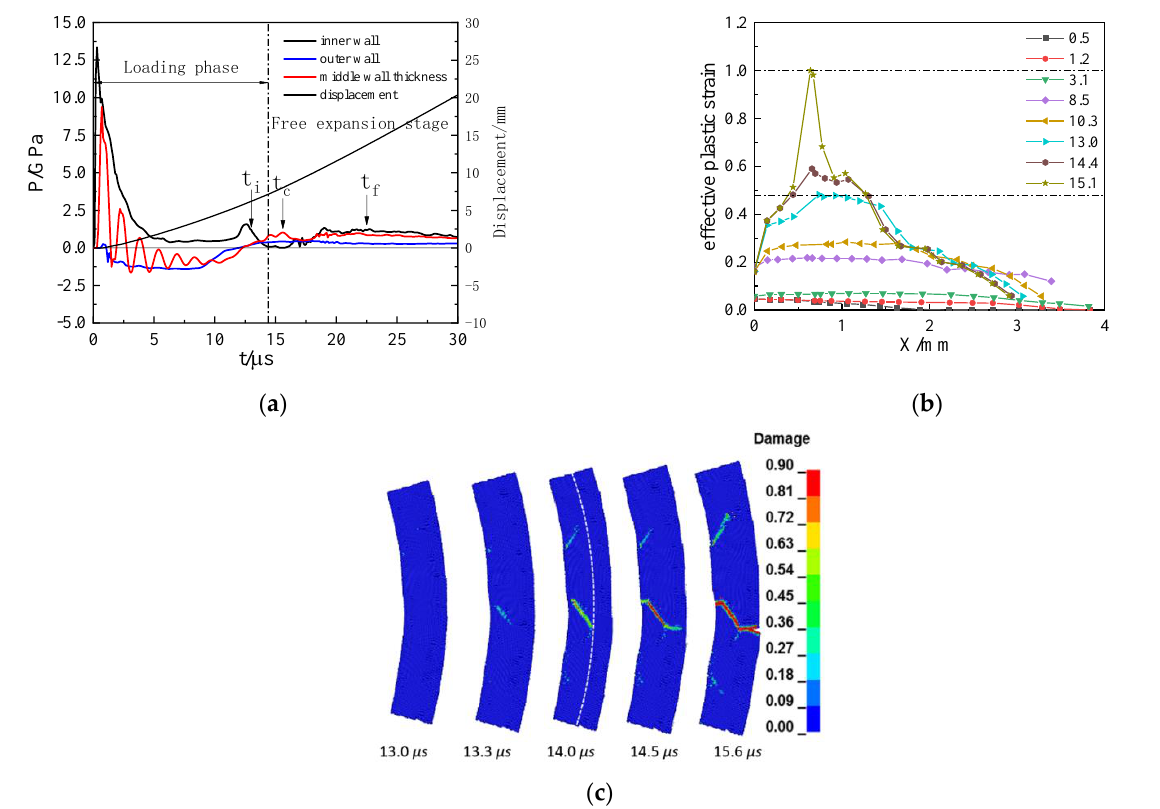
Figure 12. The explosive pressure, expanding deformation, and fracture for 45 steel cylinder shell under HNS loading: ( a ) detonation wave propagation curves; ( b ) development of effective plastic strain in shell thickness; ( c ) fracture damage evolution.